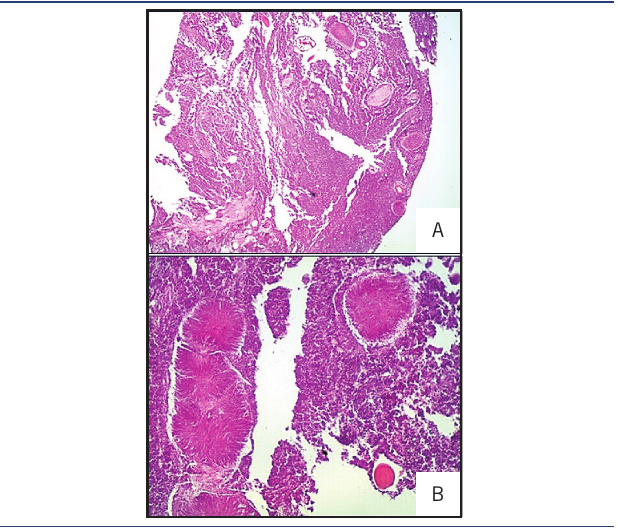
figurE 2 − Histopathological features A) photomicrograph demonstrating granulation tissue with multiple sulfur granules (HE, 100×); B) morphology detail of round eosinophilic structures with projection of thin basophilic radiating filaments, compatible with sulfur granules (HE, 400×). HE: hematoxylin and eosin.